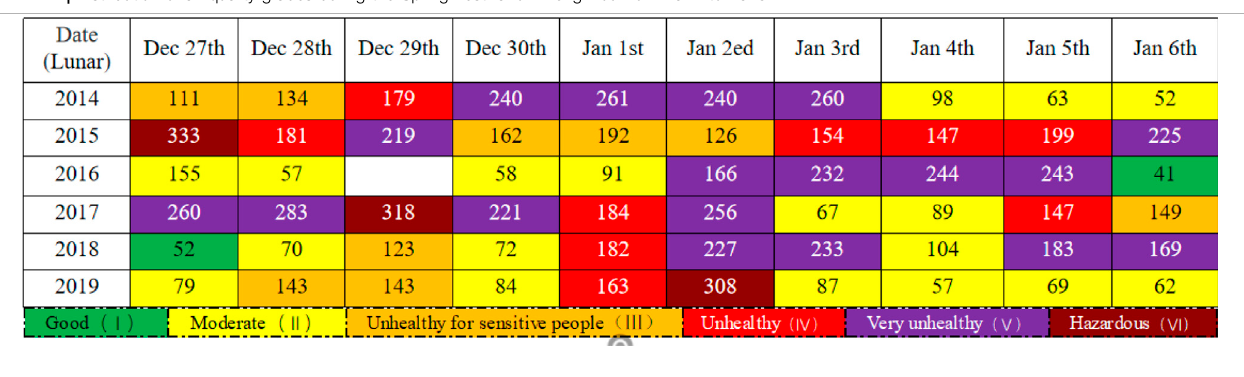
TABLE 2 | Distribution of air quality grades during the Spring Festival of Zhengzhou from 2014 to 2019.